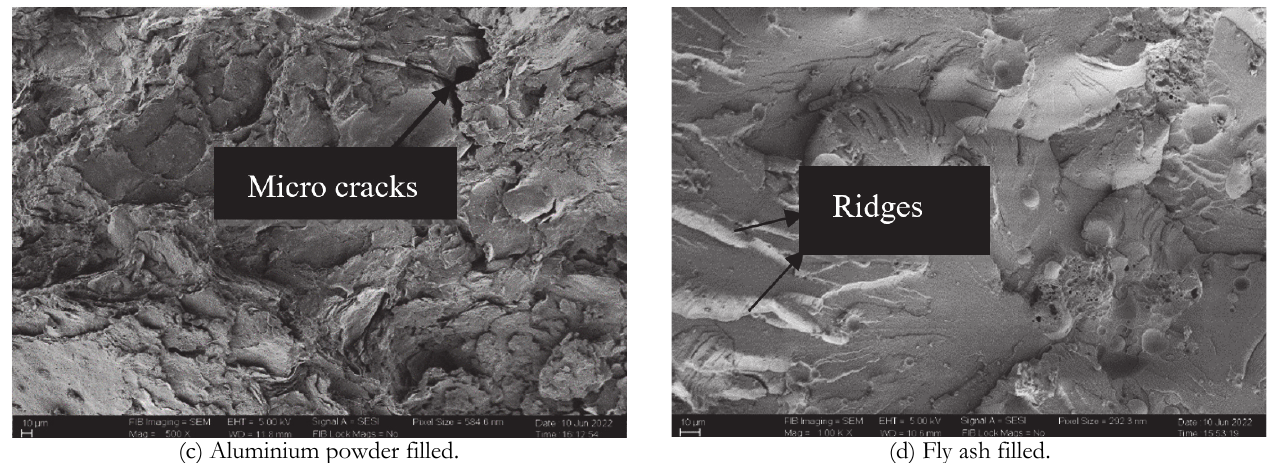
Figure 6: SEM images of impact test fractured surfaces of neat epoxy and its composites.